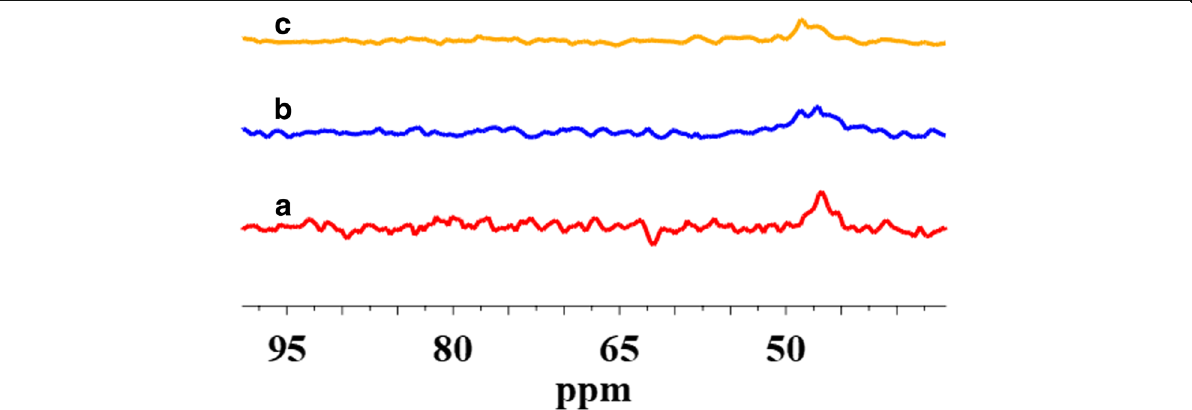
Fig. 14 13 C CP/MAS NMR spectra of ( a ) modified fumed silica with neat CPDMS, modified with ( b ) mixtures of CPDMS and dimethyl carbonate and ( c ) mixtures of CPDMS and diethyl